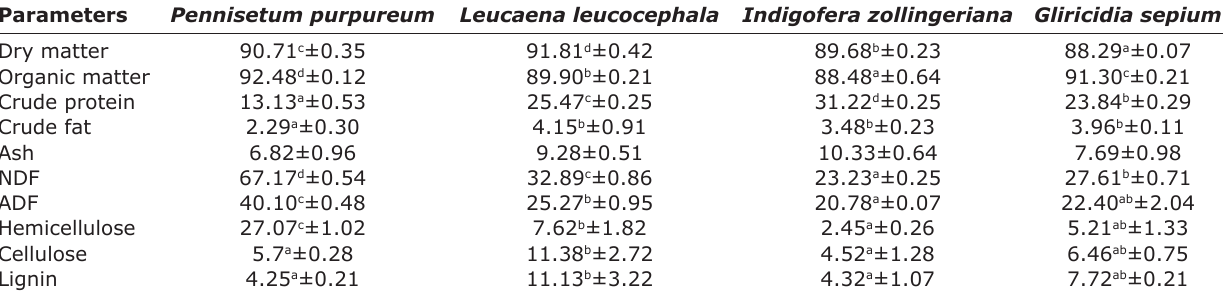
Table-1: Proximate and Van Soest analysis of forages (% of dry matter). Parameters